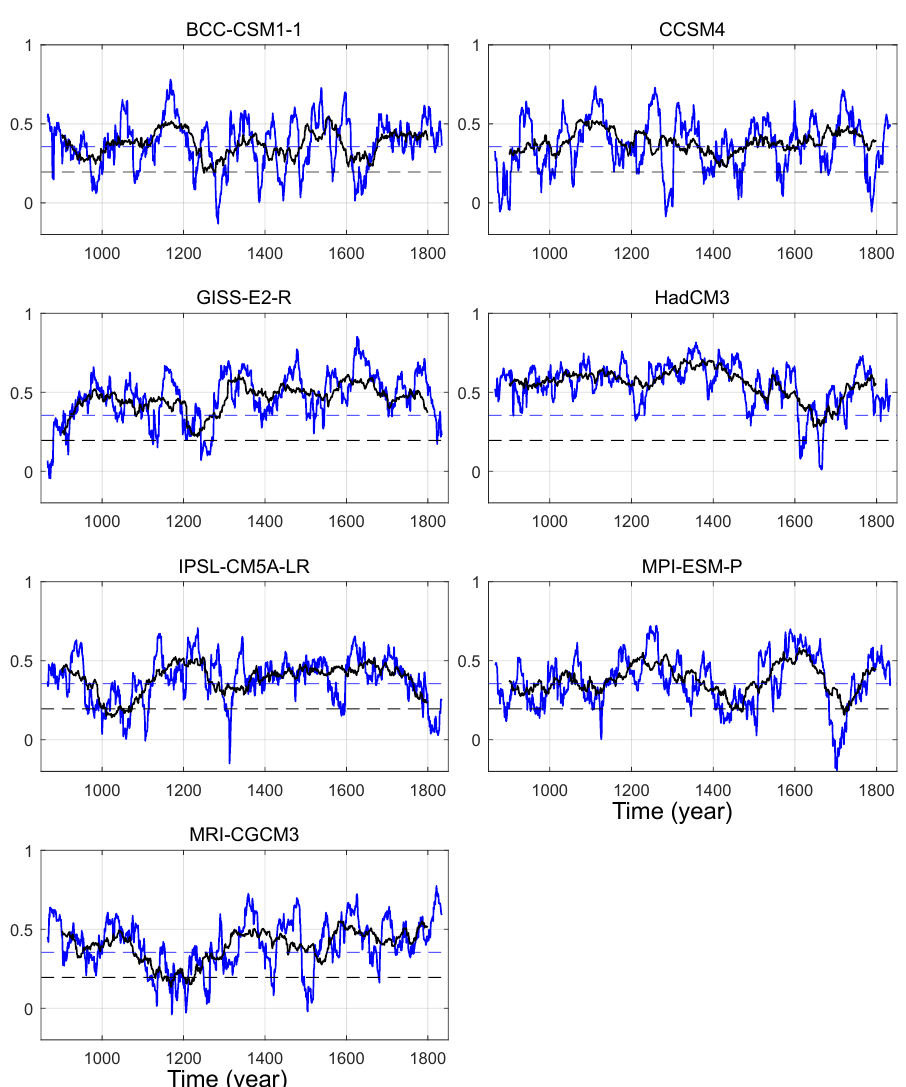
Figure 6. Running correlations (RCs) between the EASM strength and regionally averaged summer precipitation over eastern China (25– 45 ◦ N, 105–120 ◦ E). Blue (black) solid lines represent the 31-year (101-year) RCs, with upper blue (lower black) dashed lines shown as 95% significance test